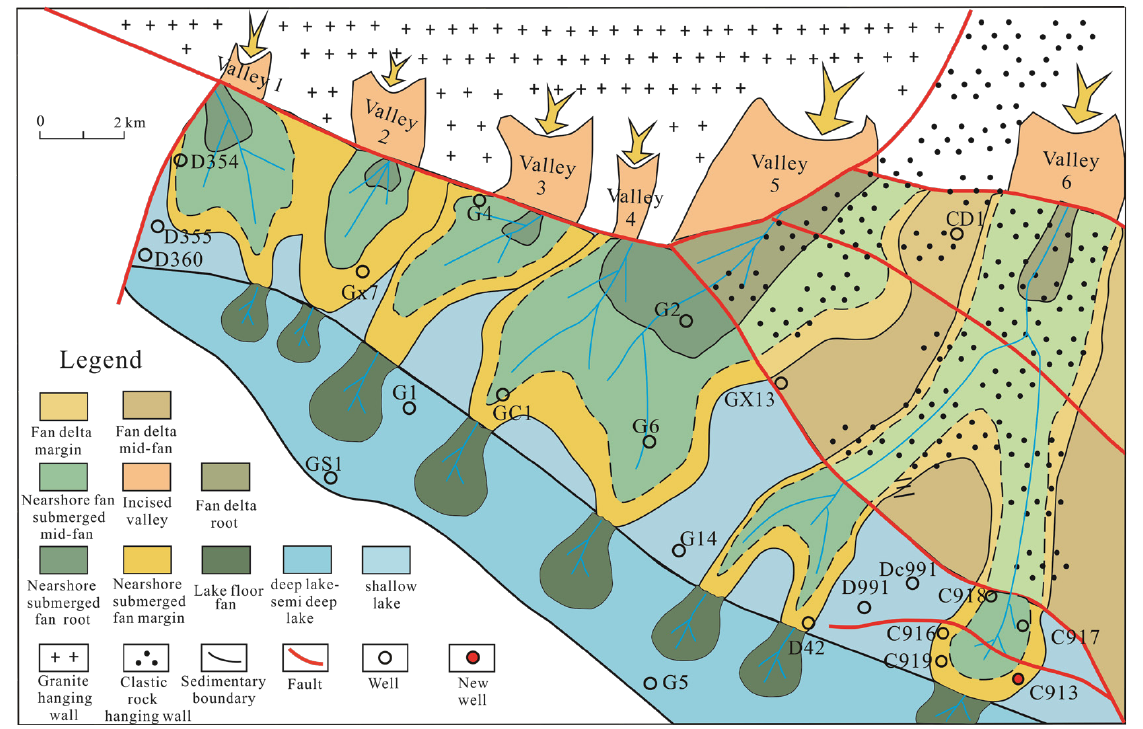
Figure 3. Incised valleys and sedimentary facies in the northern steep slope zone of the Guojuzi area.